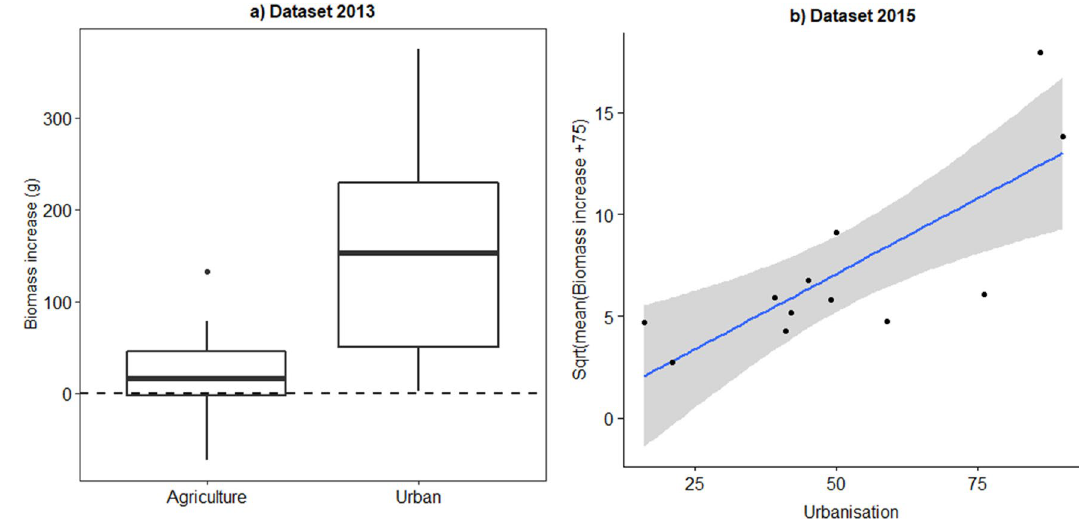
Figure 4. Biomass increase of bumble bee nests in relation to the land cover parameter urbanisation. ( A ) In the dataset of 2013 we had 3 urban locations while 3 locations had an agricultural character (each locations had 6 nests, with a total of 36 nests). ( B ) In 2015 the % urbanisation in the 6 locations showed a gradual increase (each locations had 6 nests, with a total of 36 nests). In both years urbanisation had a positive influence on the development of Bombus terrestris